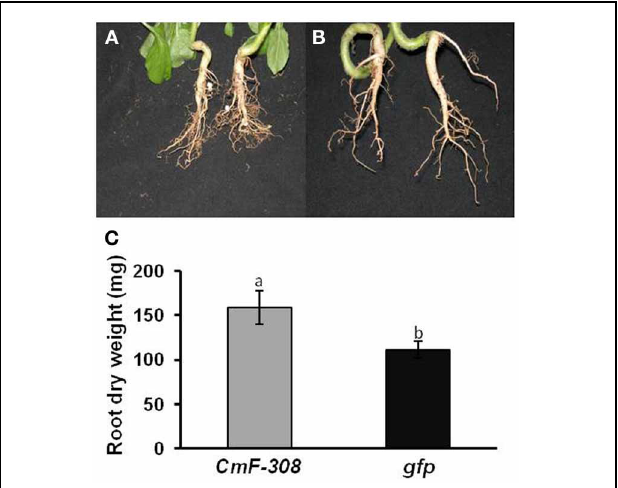
FIGURE 3 | Effect of transient expression of CmF-308 on root mass of N. benthamiana plants. Roots of pot-grown plants agroinfiltrated with plamids containing the coding sequence of CmF-308 (A) or gfp (B) . Pictures were taken 14 days after infiltration of the respective plasmids into the source leaves. (C) Root mass of hydroponically grown N. benthamiana plants 14 days after infiltration of the CmF-308 or gfp coding sequence into the source leaves. Data represent means of eight replications ± SE. Different letters indicate significant differences between plant lines at p < 0 . 05 by Student’s t -test.